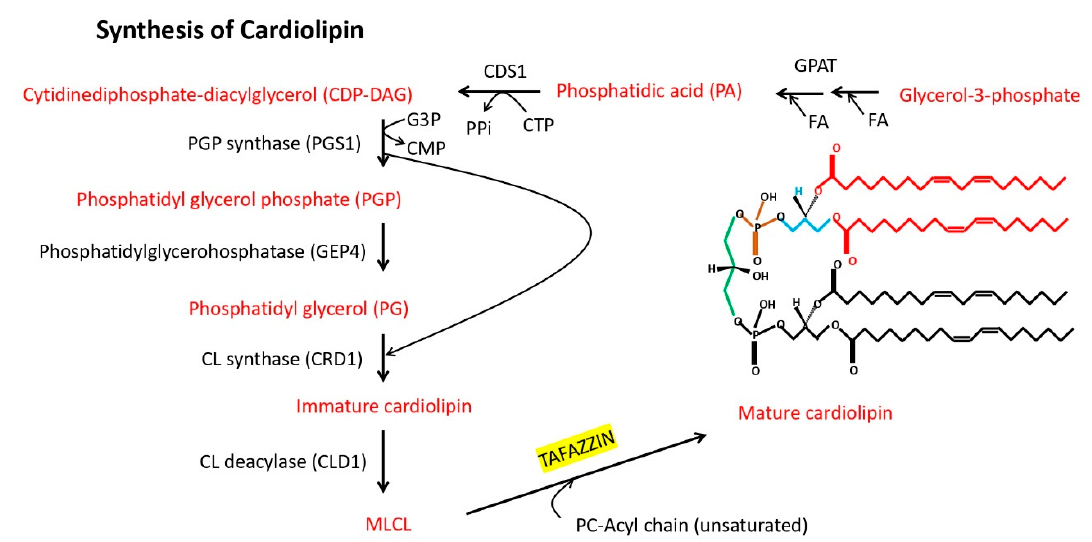
Figure 1. Biosynthesis of yeast cardiolipin (CL) within inner mitochondrial membrane. The initial steps of cardiolipin synthesis involve fatty acid esterification of glycerol-3-phosphate by glycerol-3-phosphate O-acyltransferase (GPAT) to generate phosphatidic acid (PA), which subsequently is modified by phosphatidate cytidylyltransferase 1 (CDS1) to form CDP-diacylglycerol (CDP-DAG). CDP-DAG then is modified by phosphatidylglycerolphosphate synthase (PGS1) to form phosphatidylglycerol phosphate (PGP), which is then modified by phosphatidylglycerophosphatase (GEP4) to phosphatidyl glycerol (PG). PG is then modified by cardiolipin synthase (CRD1) to form immature cardiolipin, which is then processed to MLCL by cardiolipin-specific deacylase 1 (CLD1). The yeast Tafazzin ortholog then reacylates MLCL to mature CL in mitochondria using a phosphatidylcholine acyl chain